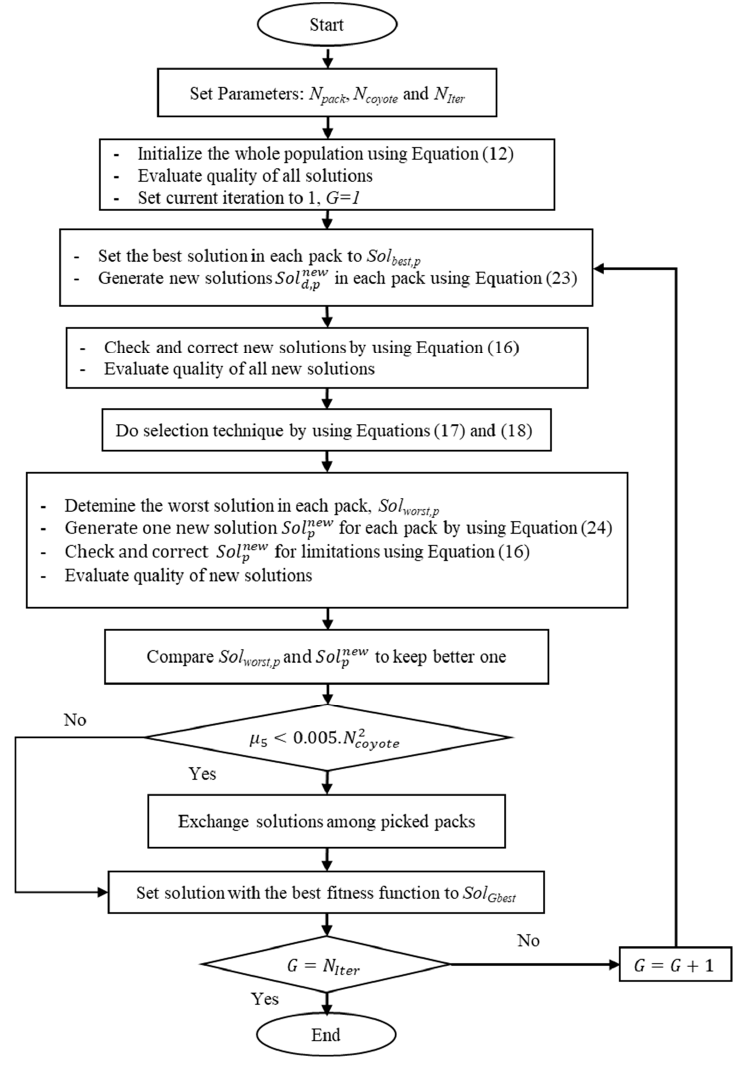
Figure 3. The flowchart of using the proposed ICOA approach for a typical optimization problem.